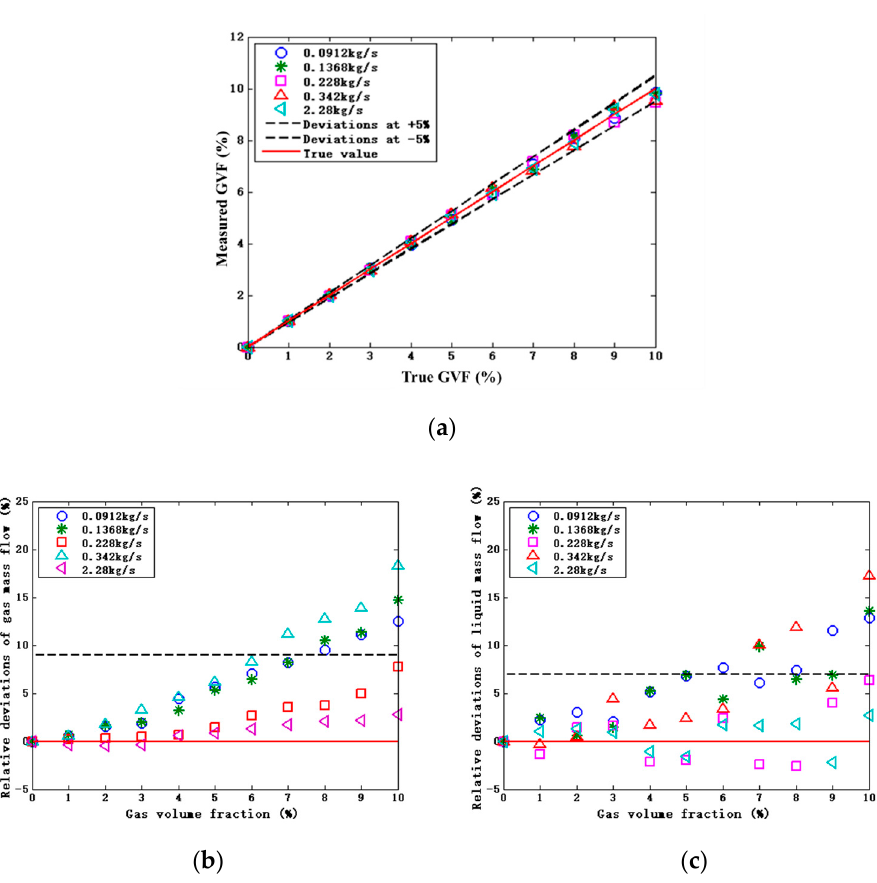
Figure 9. The deviations relative to GVF after correction by the proposed compensation model. ( a ) Gas-phase content. ( b ) Relative deviations of Gas-phase mass flow. ( c ) Relative deviations of Liquid-phase mass flow.